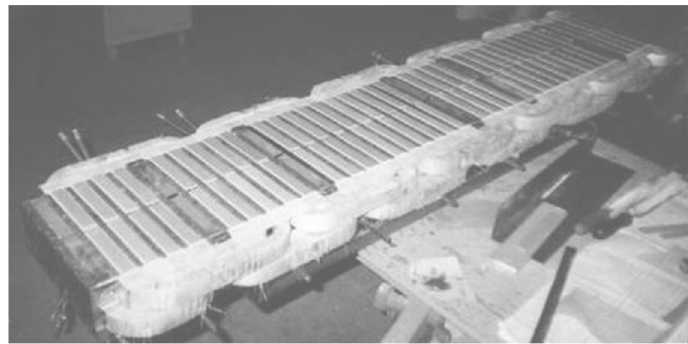
Figure 11. The traction LIM primary at the winding installation stage. Table 4. Parameters of the traction LIM of the urban transportation system.